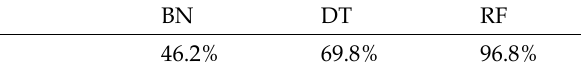
Table 3. Correctly identified instances (CCI) among the three